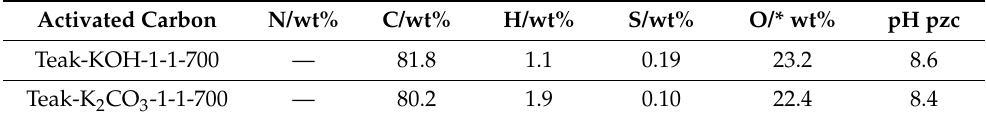
Table 3. Chemical characteristics of the ACs produced from Tectona Grandis sawdust, by chemical activation with KOH and K 2 CO 3 , at 973 K. (* O 2 obtained by EDX). Activated Carbon N/wt% C/wt%